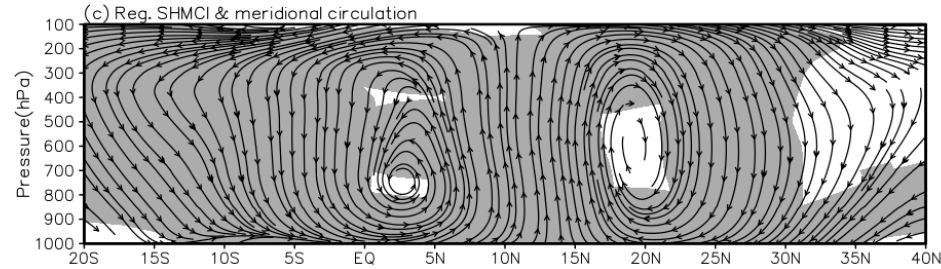
Figure 3. ( a ) Climatology of the zonally averaged (120 ◦ E–155 ◦ E) vertical meridional circulation during 1979–2017 in a latitude–height cross-section, the red line represents the approximate boundary between the ascending branch and descending branch; ( b ) The streamlines show the linear regression map between the Northern Hemisphere meridional circulation index (NHMCI) and the summer zonally averaged (120 ◦ E–155 ◦ E) vertical meridional circulation; ( c ) The same as ( b ) except it is for the Southern Hemisphere meridional circulation index (SHMCI). The shaded regions represent the anomalous meridional wind and vertical wind significant at the 95% confidence level. The vertical velocity has been multiplied by − 100.